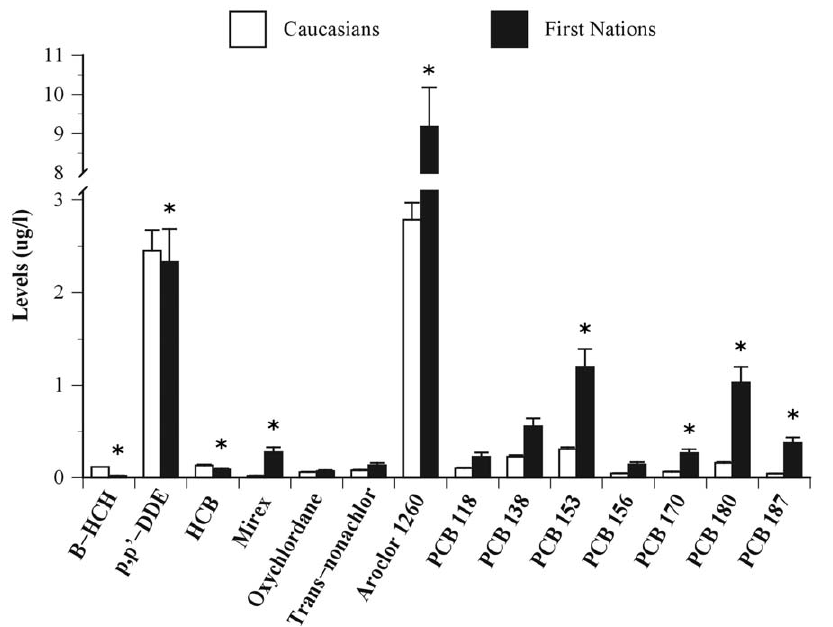
Figure 1. Plasma persistent organic pollutant levels (in m g/l) of Caucasians from the southern province of Que´bec (Canada) and First Nations from northern remote communities of Ontario (Canada). Significant difference between groups at * p , 0.05.